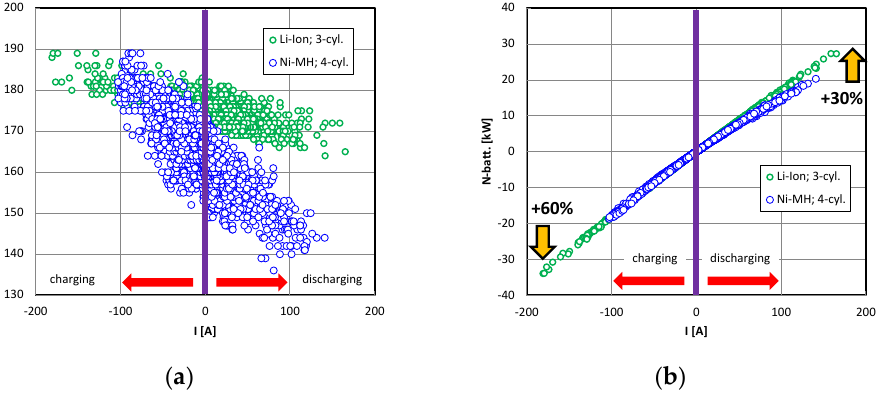
Figure 6. Battery charging and discharging conditions: ( a ) Li-ion (newer, 3-cylinder solution) and Ni-MH (older 4-cylinder solution); ( b ) power characteristics of the